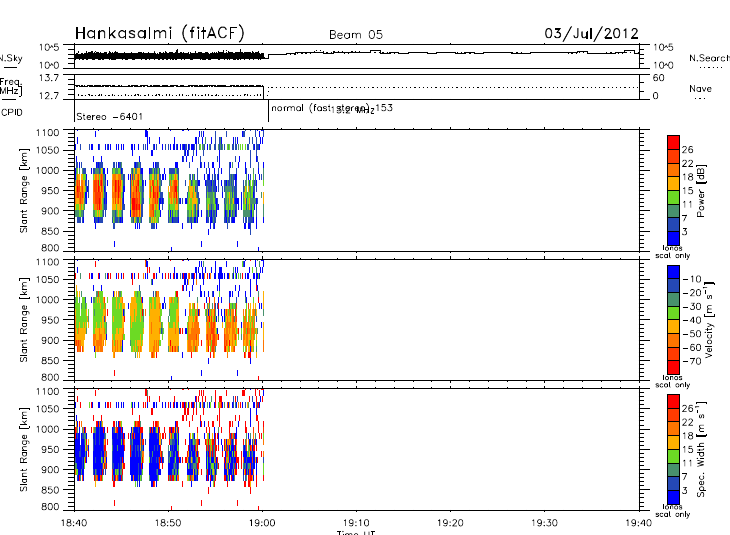
Figure 4. The results of HF pumping during 18:40–19:40UT on 3 July 2012. The upper panel shows the pump frequency, where the black arrows indicate the pump frequency 4.04MHz (approximately 3 f c e ) at 18:52–18:53 and 19:14–19:15UT. The middle panel shows the electron temperature profile measured by the EISCAT UHF radar with the integration time 60s. The lower panel shows CUTLASS backscatter power, Doppler velocity, and spectral width vs. slant range (line-of-sight distance) in the heating region over EISCAT.